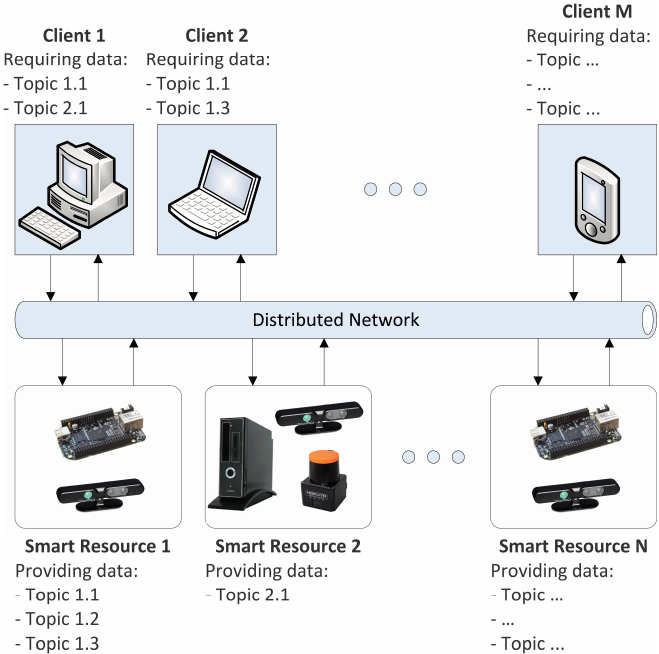
Figure 9. Scalability of the